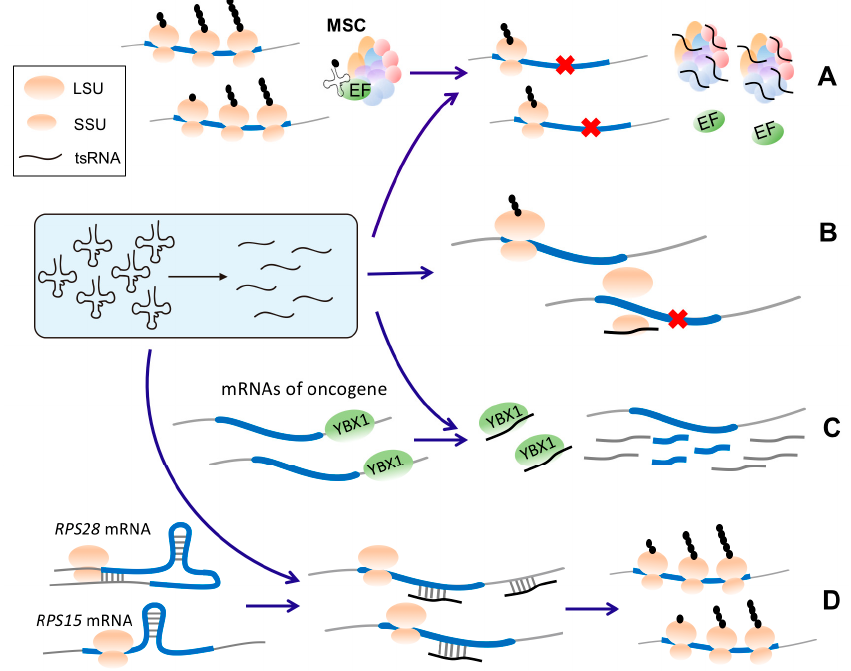
Figure 2. The Argonaute (AGO)-independent translation regulation modes mediated by tsRNAs. ( A ) In human cells, the multi-synthetase complex (MSC) can associate with elongation factors (EFs) to deliver charged tRNAs to the ribosomes. A 5 ′ -tsRNA Gln interferes with this process by interacting with MSC, which impedes protein translation. ( B ) In Haloferax volcanii , 5 ′ -tsRNA Val can bind to small ribosomal subunits, which inhibits formation of the translation initiation complex and reduces protein translation under stress conditions. ( C ) Certain oncogenic mRNAs are stabilized if their 3 ′ UTRs are bound by YBX1. In breast cancer cells, several tsRNAs can competitively bind to YBX1, which destabilizes such oncogenic mRNAs by displacing them from YBX1. ( D ) A 22-nt 3 ′ tsRNA-Leu CAG binds the mRNAs of two ribosomal proteins ( RPS28 and RPS15 ) to unfold their secondary structures and enhance their translation. For RPS28 mRNA, one target site of 3 ′ tsRNA-Leu CAG is located in the coding sequence (CDS) and the other target site is located in 3 ′ UTR; for RPS15 mRNA, the tsRNA target site is located in CDS.